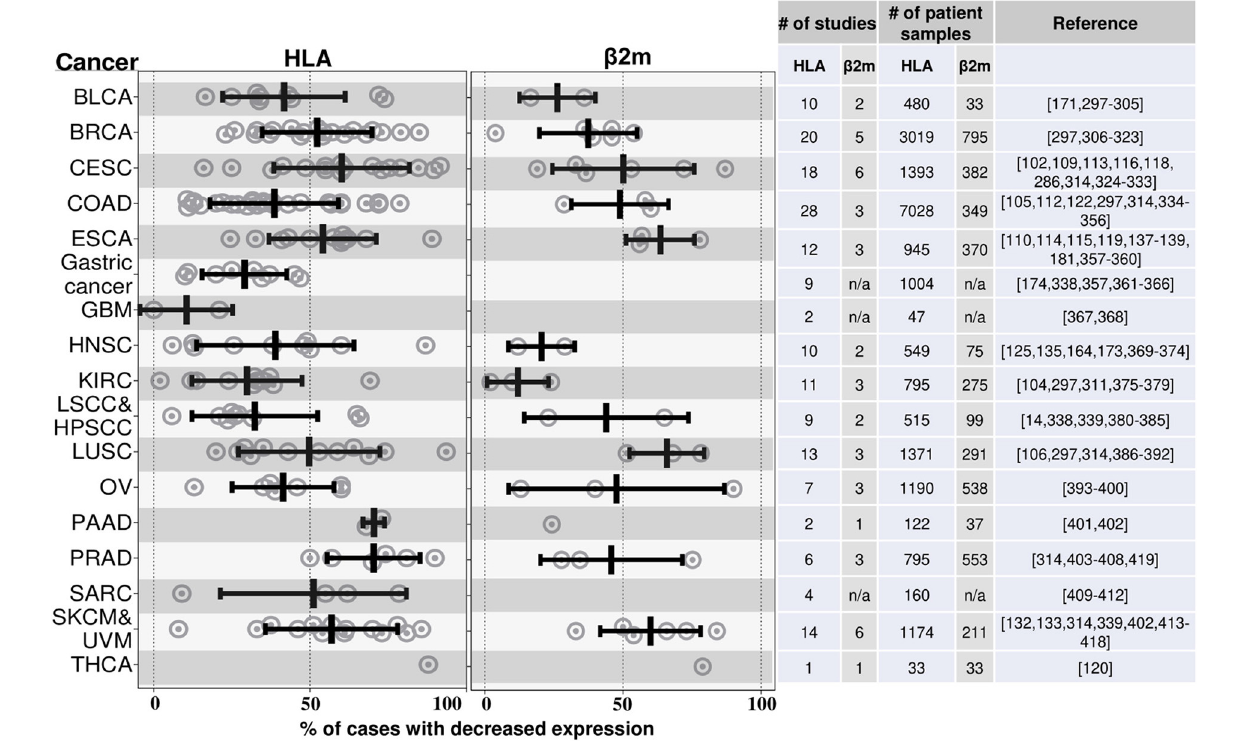
FIGURE 4 | HLA and β 2M are frequently downregulated in many different cancers. This graph illustrates the findings from a number of studies that have measured MHC I expression in various cancers by immunohistochemistry. Cancers are annotated by their TCGA abbreviations (see abbreviation list). Each dot represents the percent of cases with loss of MHC I expression in an individual study. The mean % reductions and standard deviations for all of the studies combined are shown by the black bars. The data to the right of the graph shows the number of studies and number of patients samples used to quantify the MHC class I. The studies that were included are shown in the references; this is not an exhaustive list of all such analyses. BLCA, Bladder urothelial carcinoma; BRCA, Breast invasive carcinoma; CESC, Cervical squamous cell carcinoma and endocervical adenocarcinoma; COAD, Colon adenocarcinoma; ESCA, Esophageal carcinoma; GBM, Glioblastoma multiforme; HNSC, Head and neck squamous cell carcinoma; KIRC, Kidney renal clear cell carcinoma; LSCC, Lung squamous cell carcinoma; HPSCC, Hypopharyngeal squamous cell carcinoma; LUSC, Lung squamous cell carcinoma; OV, Ovarian serous cystadenocarcinoma; PAAD, Pancreatic adenocarcinoma; PRAD, Prostate adenocarcinoma; SARC, Sarcoma; SKCM, Skin cutaneous melanoma; UVM, Uveal melanoma; THCA, Thyroid carcinoma; IFN, Interferon; LIHC, Liver hepatocellular carcinoma; NSCLC, Nonsmall cell lung